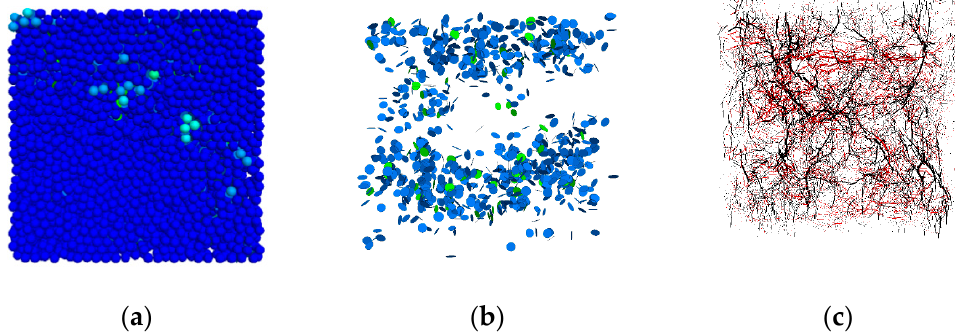
Figure 24. The failure mode of the foamed concrete with a density of 750 kg/m 3 at a loading rate of 0.06 mm/min. ( a ) model failure mode; ( b ) crack development; ( c ) force-chain distribution.